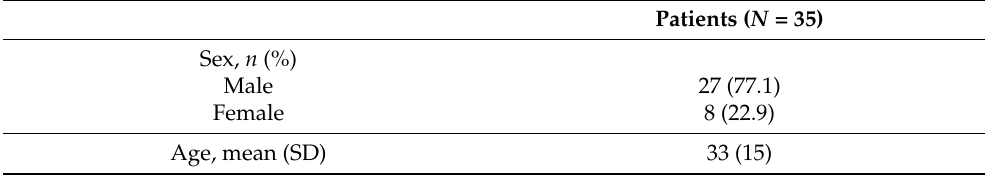
Table 1. Baseline